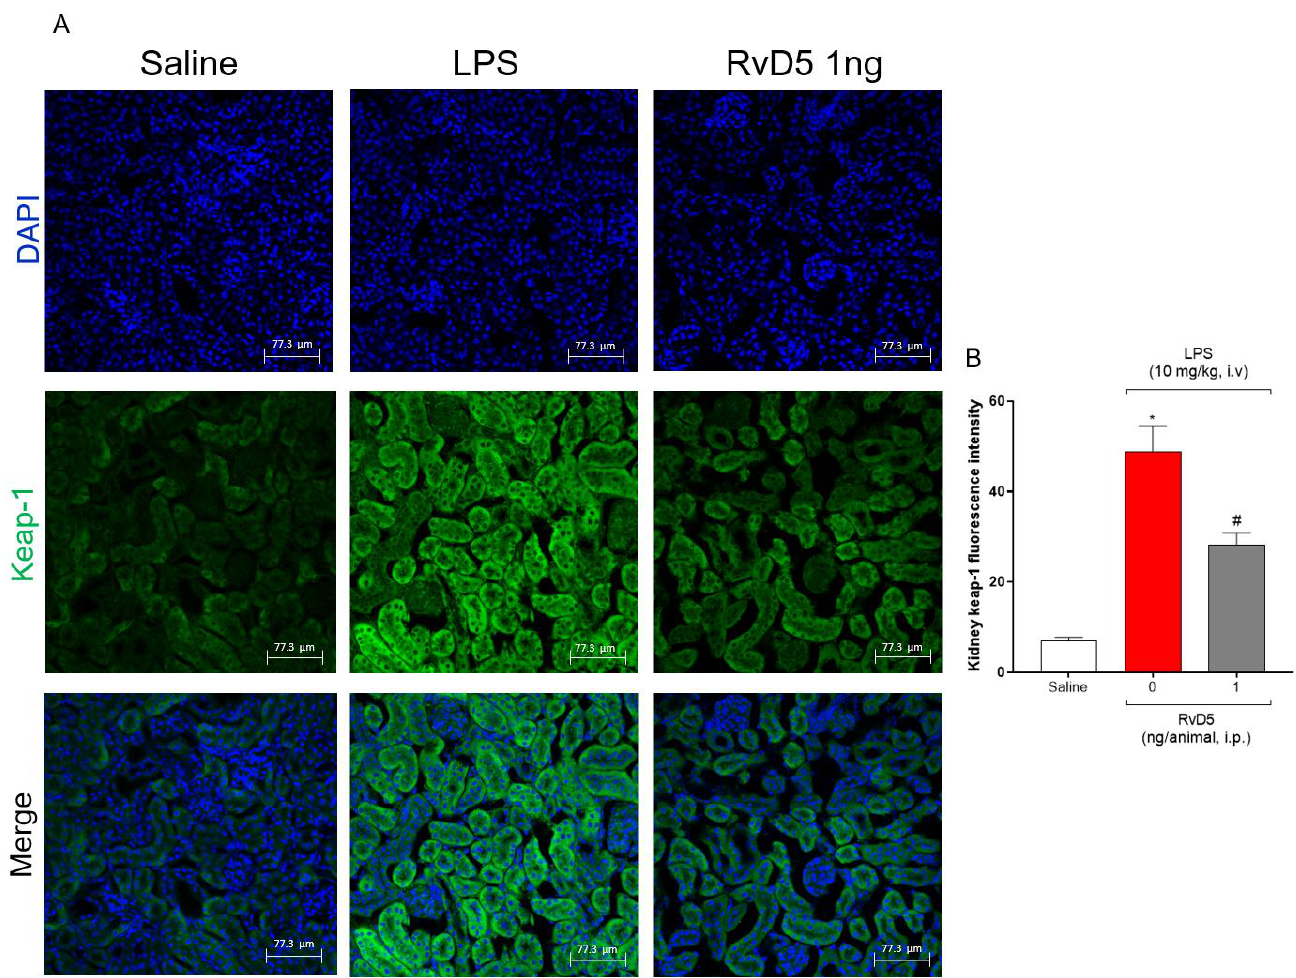
Figure 9. RvD5 reduces Keap-1 staining in the kidneys. Representative images ( A ) and Keap-1 fluorescence intensity ( B ). Results are presented as standard ± SEM (standard error mean) one-way ANOVA followed by Tukey’s post-test) of six animals per group and are representative of two replicates. Scale bar: 77.3 µm. (* p < 0.05 vs. saline, # p < 0.05 vs. LPS 10 mg/kg).